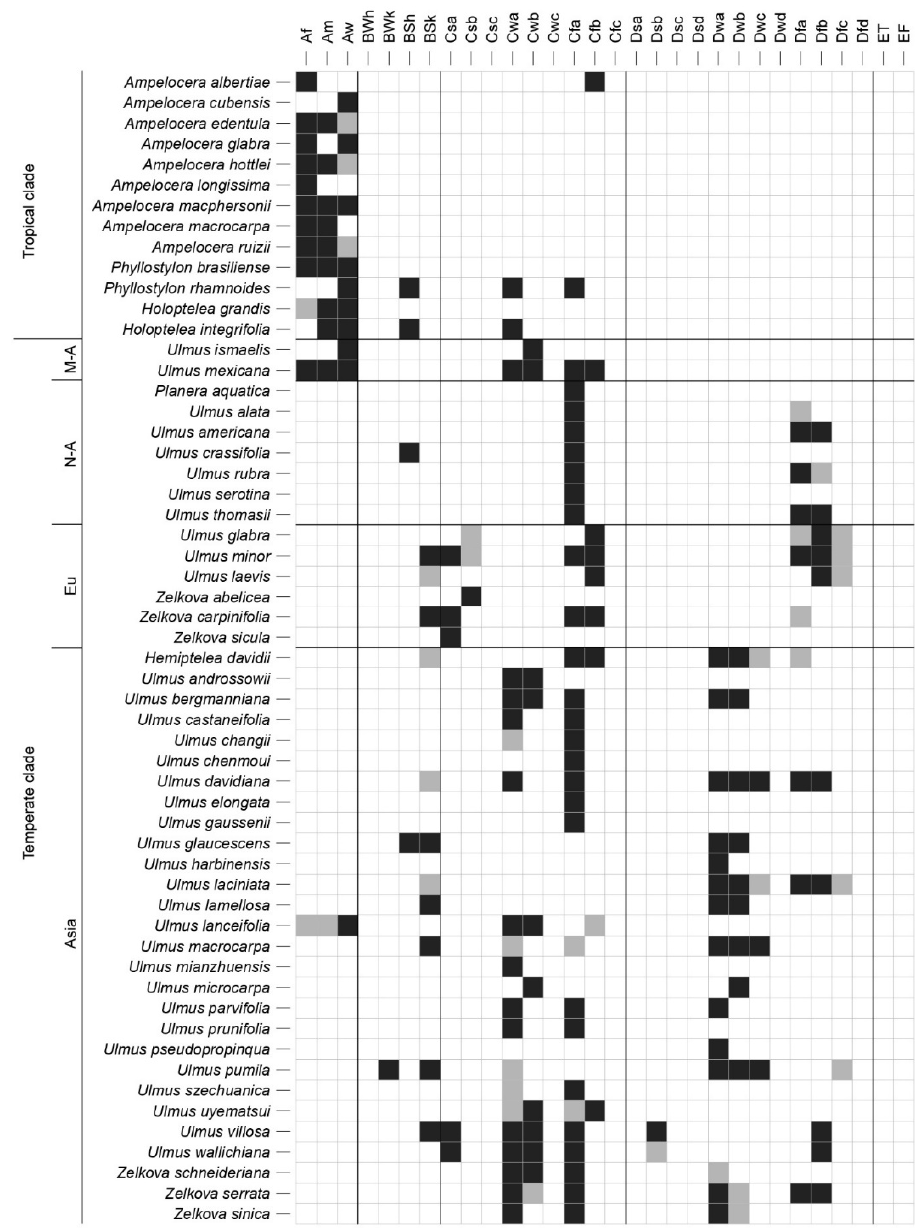
Figure 3. Realized (macro)climatic niches for each species of the Ulmaceae family, according to the Köppen–Geiger climate classification. A black square indicates that a species is largely distributed in the corresponding climate, and a grey square indicates that the species is only marginally distributed in the corresponding climate. The species are presented in the following order from top to bottom: tropical clade and temperate clade, further divided in Mesoamerica (M-A), North America (N-A), Europe (Eu), and Asia. The upper abbreviations indicate the type of climate: tropical rainforest climate (Af), tropical monsoon climate (Am), tropical savanna climate (Aw), arid climate (BW; h—hot, k—cold), semiarid (steppe) climate (BS; h—hot, k—cold), Mediterranean climate (Cs; a—hot summer, b—warm summer, c—cool summer), humid subtropical climate (Cfa), oceanic climate (Cfb), subpolar oceanic climate (Cfc), dry-winter humid subtropical climate (Cwa), dry-winter subtropical highland climate (Cwb), dry-winter subpolar oceanic climate (Cwc), continental climate (D; s—dry summer, w—dry winter, f—no dry season; a—hot summer, b—warm summer, c—cold summer, d—very cold winter), tundra climate (ET), and ice climate